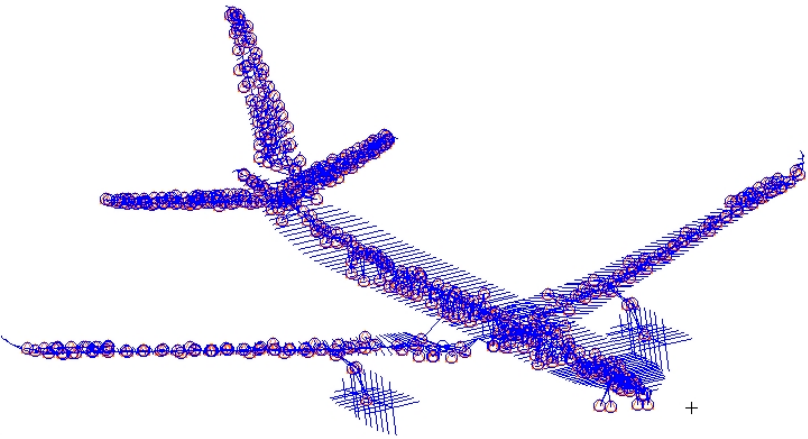
Figure 4. Structural model for static aeroelastic analysis based on linear aerodynamics. The structural model for the CFD/CSD coupling method is shown in Figure 5. A half structural model was used, corresponding to the half CFD model in Figure 3, and sym ‐ metric constraints were applied at the plane of symmetry. The beam elements and lumped mass elements were the same as the structural model in Figure 4, but the auxiliary inter ‐ polation points constructed for the interpolation of force and displacement were different when the thin plate spline (TPS) method was used. The inertial relief method [10,11] was used for the free–free system, and the supported point was at the center of mass.